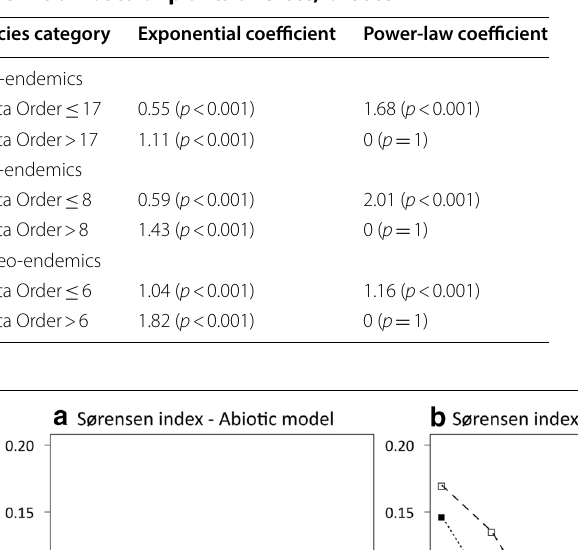
Table 2 The estimated coefficients and the significance of the fit of the exponential and power-law of the zeta decline for non-endemic, neo-endemic, and palaeo-